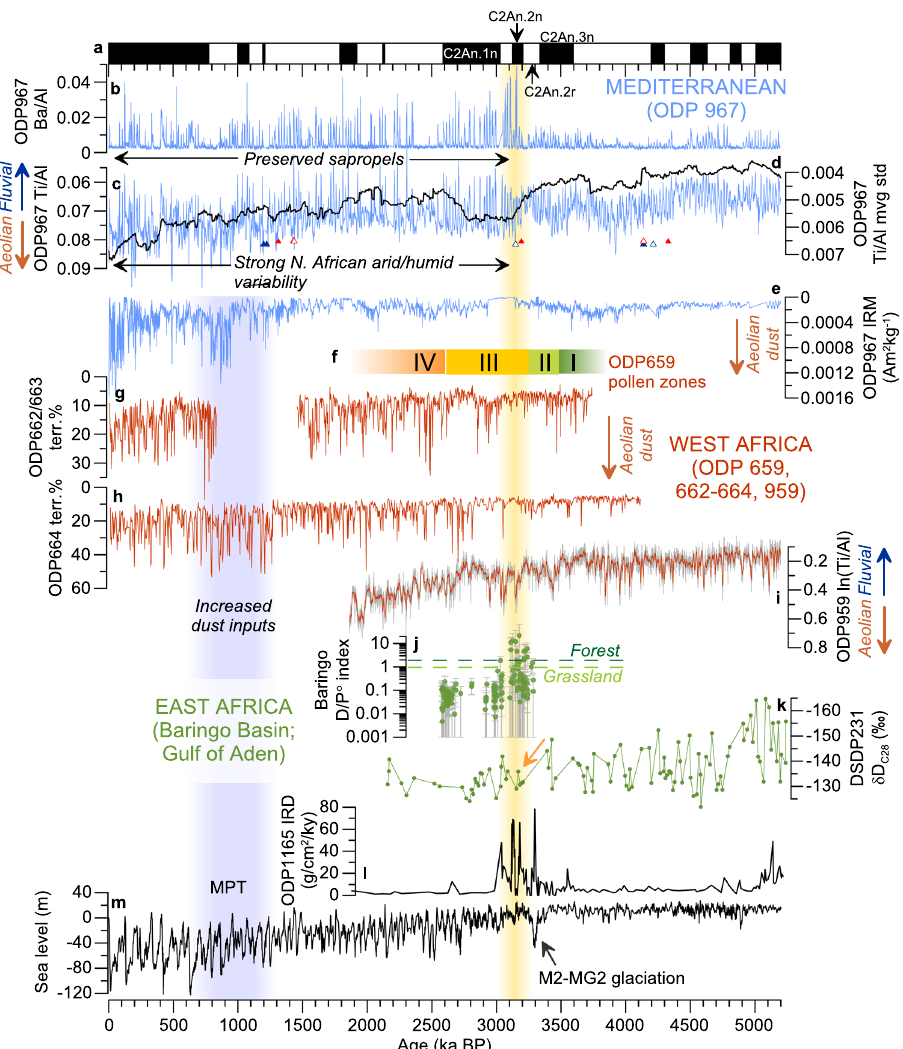
Fig. 4 Chronological and environmental context for the geochemical shift at ODP Site 967 at 3.2 Ma (see Fig. 1 for site locations, except ODP Site 1165 which is offshore Prydz Bay, Antarctica). a Tectonic event around Sicily 54 in Chron 2An.2n; b – e ODP967 Ba/Al, Ti/Al, 400-kyr moving standard deviation of Ti/Al (black) and magnetic dust proxy (IRM 900@120mT ) (this study). Change-points in ( c ) are based on changes in the mean (red) and standard deviation (blue) of the Ti/Al time-series (closed triangles) and Ti/Al residuals (open triangles) after removing low-frequency (140 – 1200 kyr) variability; f pollen zones from ODP Site 659 ref. 32 (green = more humid; yellow/orange = increasing aridity and humid/arid variability); g , h aeolian dust records from offshore West Africa 24, 25 , i ODP Site 959 Ti/Al (grey) 28 with 11-point running average (red); j tree index based on phytoliths from Baringo Basin core BTB13, with 95% con fi dence intervals 37 (downward bars limited to the y-axis); k DSDP Site 231 leaf wax δ D with inferred shift to more aridity at 3.3 – 3.0 Ma ref. 38 , l ODP Site 1165 ice-rafted debris (IRD) fl uxes 51 , m global sea-level reconstruction 79 based on benthic δ 18 O (ref. 69 ). All records are plotted on their original chronology. Vertical shading denotes the Mid-Pleistocene Transition (MPT; grey) and geochemical shift at ODP967 (yellow).